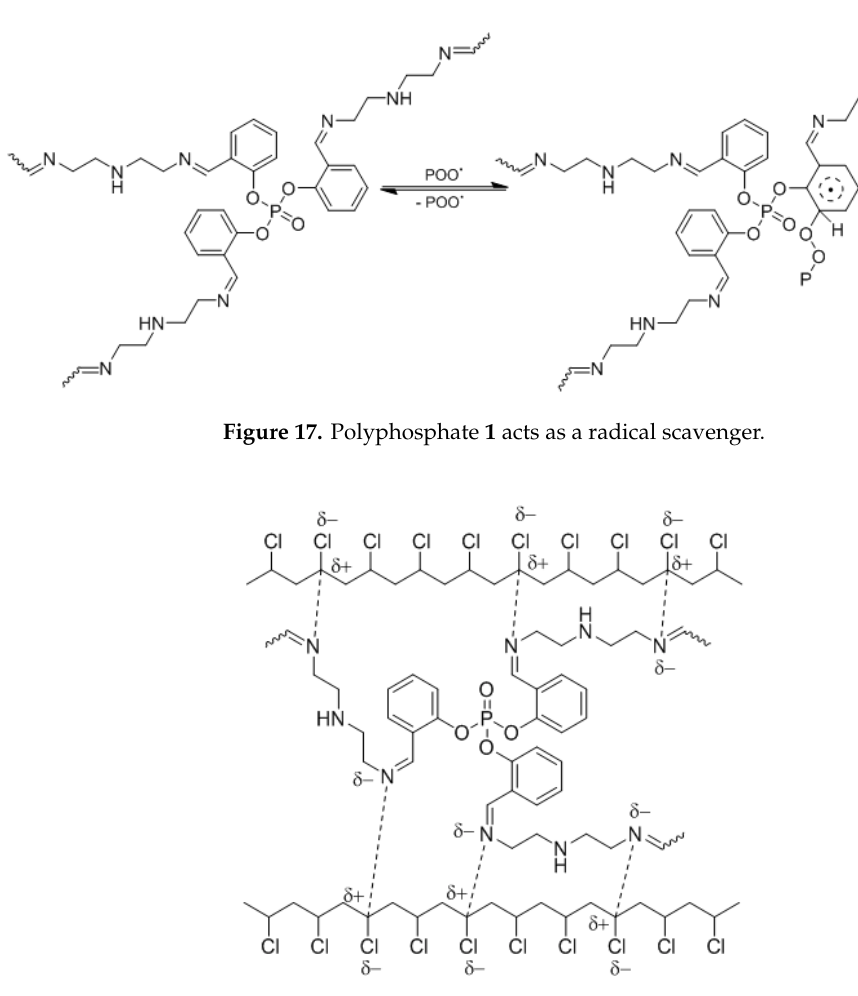
Figure 16. Polyphosphate 1 acts a UV absorber.